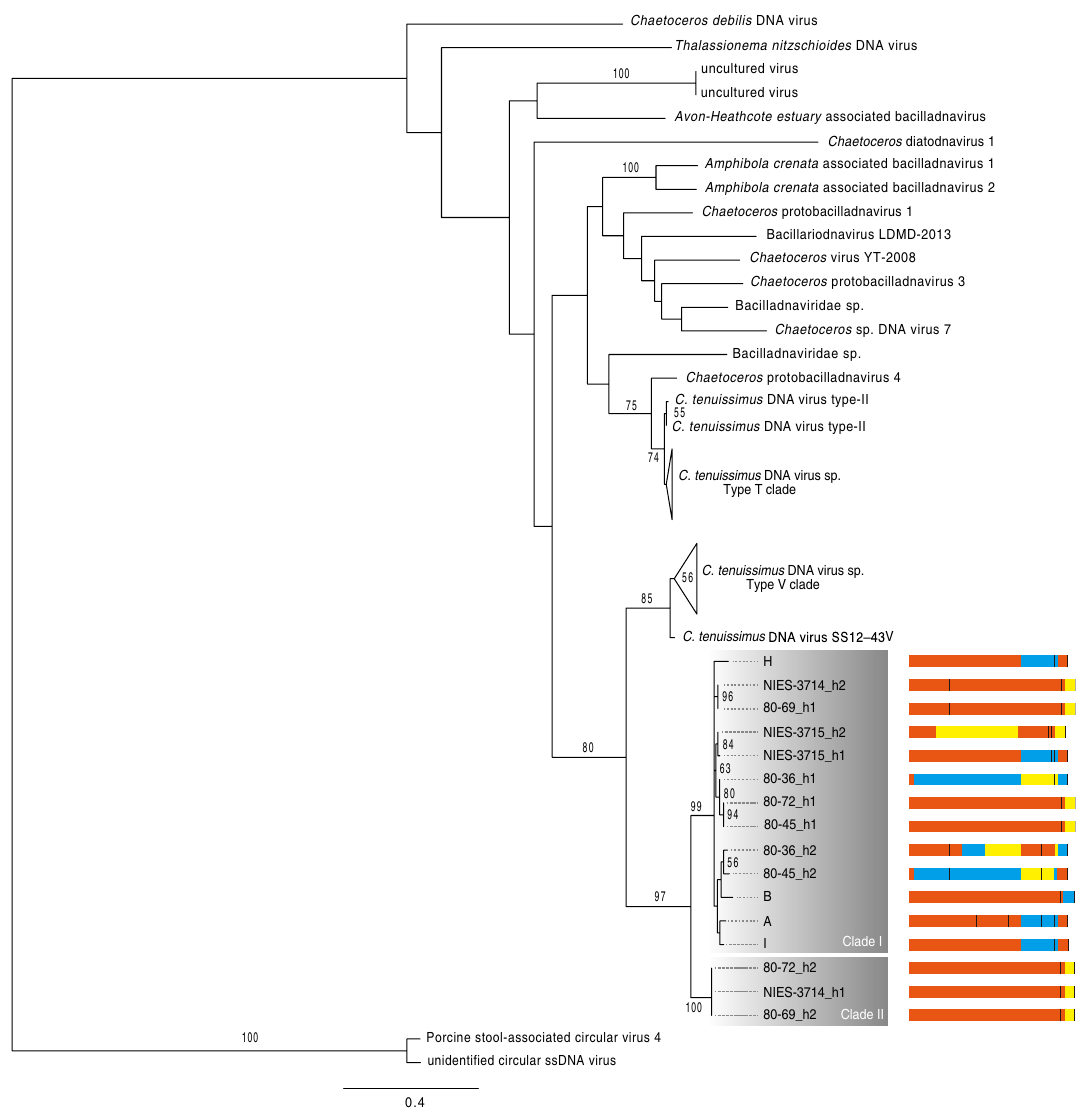
Figure 3. Maximum-likelihood trees of EVLFs with the replication-associated protein from bacilladnavirus. The EVLF fragment structures were shown in EVLF clade. The red, blue, and yellow boxes indicate the 1st, 2nd, and 3rd frames, respectively. The black vertical lines indicate the terminal codons. Bootstrap values greater than 50% are